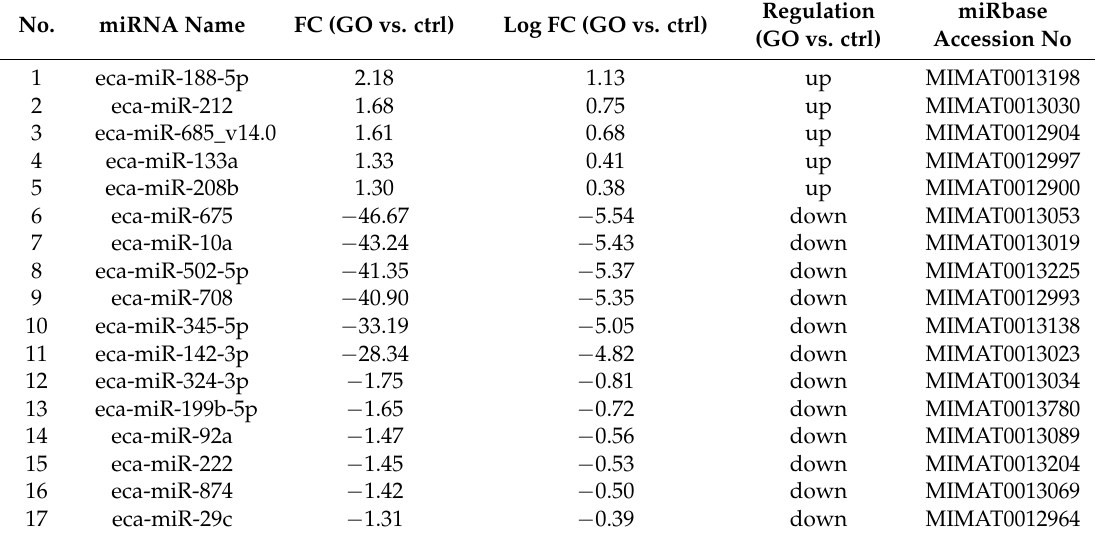
Table 2. MiRNAs differentially expressed in GO-incubated equine satellite cells exposed to H 2 O 2, compared to control.